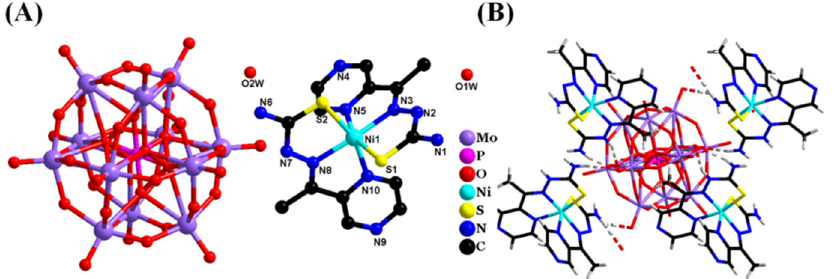
Figure 1. ( A ) The molecular structure of 1 . ( B ) H-bond interactions between [Ni(L 2 )(HL 2 )] + and [PMo 12 O 40 ] 3 − .